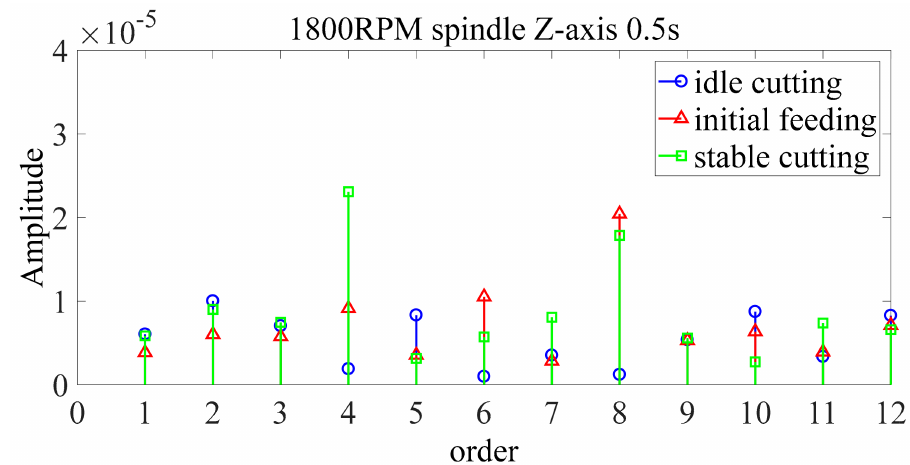
Figure 11. Order spectrum at Z axis at 1800 rpm; removing features not related to rotation